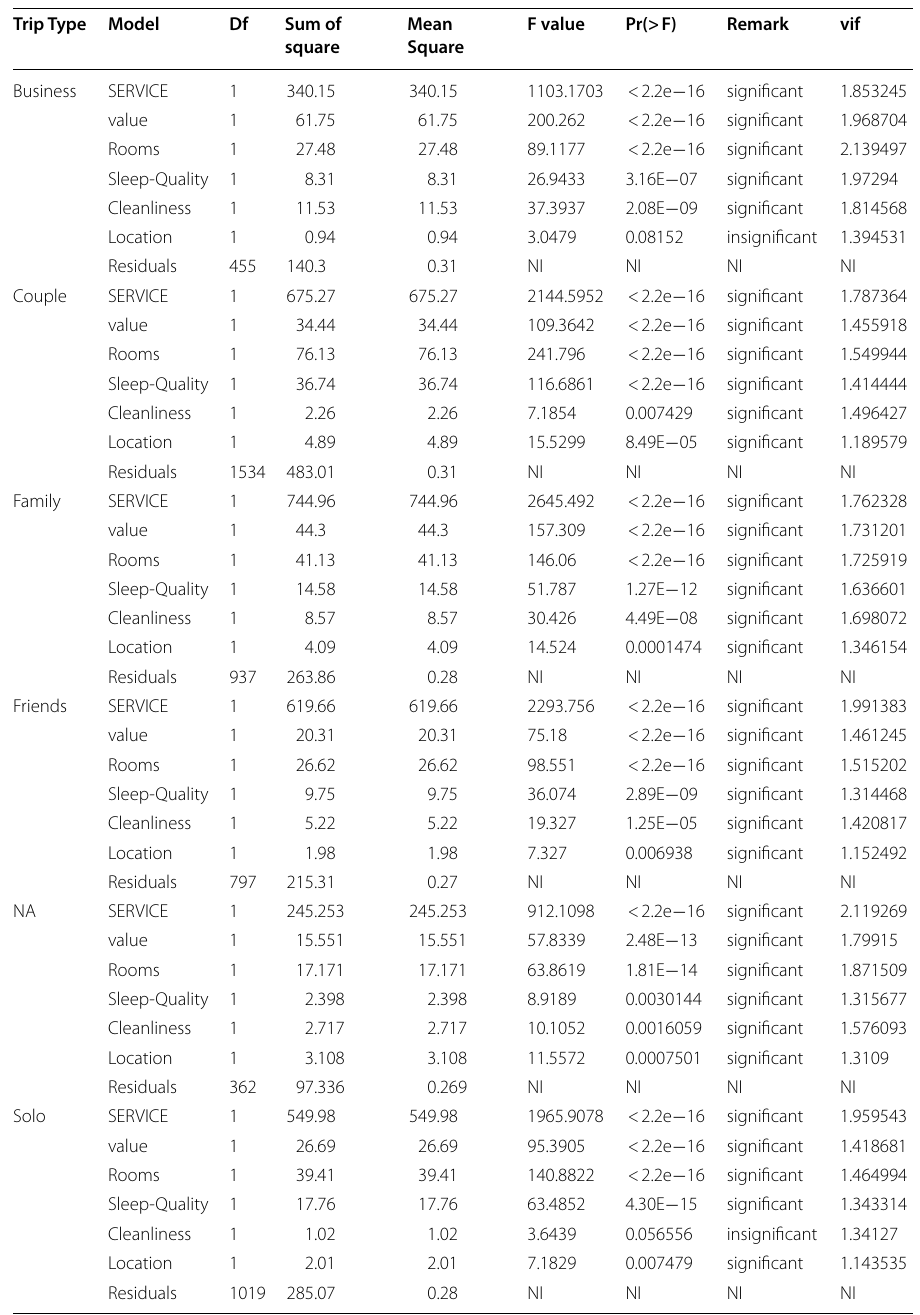
Table 12 Analysis of Variance of 2 star hotel class based on trip